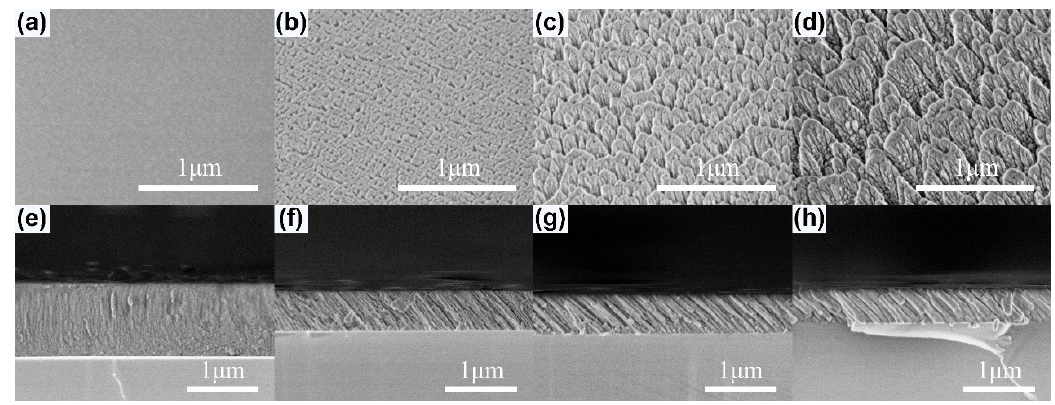
Figure 3. Top views ( a – d ) and cross-sectional views ( e – h ) of the FE-SEM images for YF 3 films deposited at 0° ( a , e ), 70° ( b , f ), 78° ( c , g ), and 82° ( d , h ), respectively.